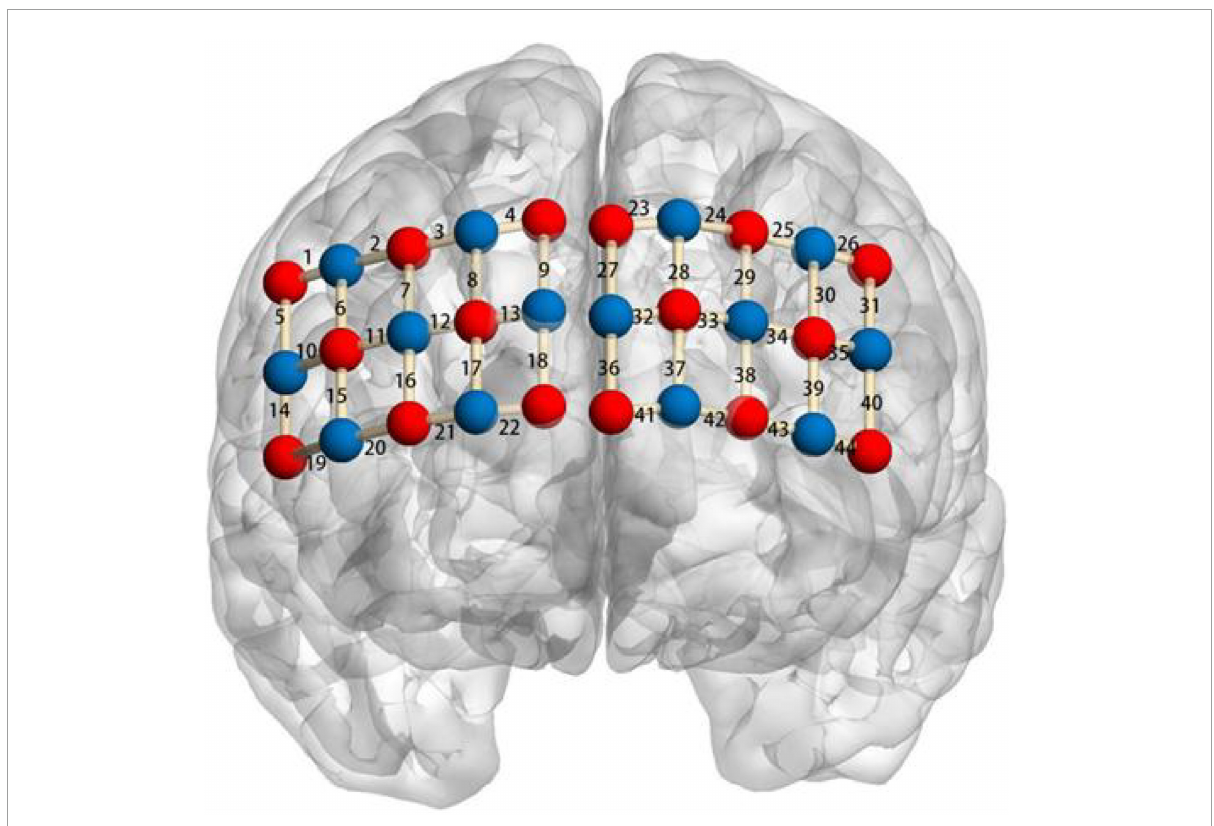
FIGURE4 Localization of regions of interest. Right Ventrolateral prefrontal cortex (VLPFC): channel 16, 17, 21, 22; left VLPFC: channel 38, 39, 42, 43; right dorsolateral prefrontal cortex (DLPFC): channel 3, 4, 7, 8, 9, 12, 13; left DLPFC: channel 24, 25, 28, 29, 30, 33, 34; right posterior superior frontal cortex (PSFC): channel 1, 2, 5, 6; left PSFC: channel 26, 31; right temporal cortex (TC): channel 10, 11, 14, 15, 19, 20; left TC: channel 35, 40, 44; and Medial prefrontal cortex (MPFC): channel 18, 23, 27, 32, 36, 37,